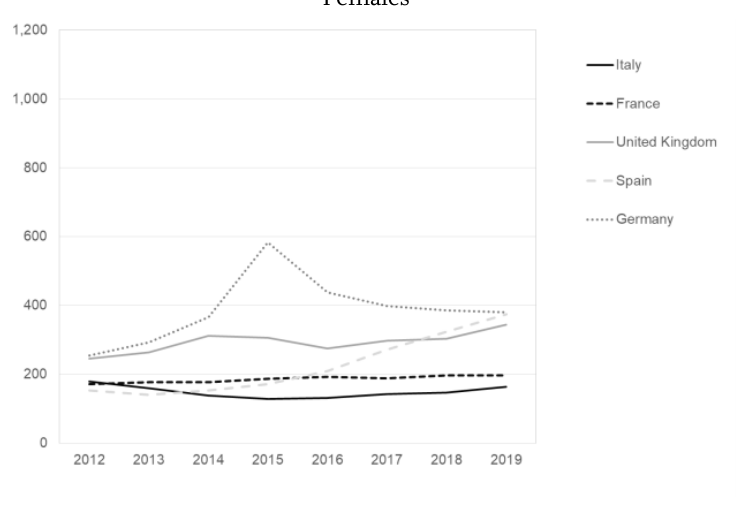
Annual immigrants to major EU countries, in thousands